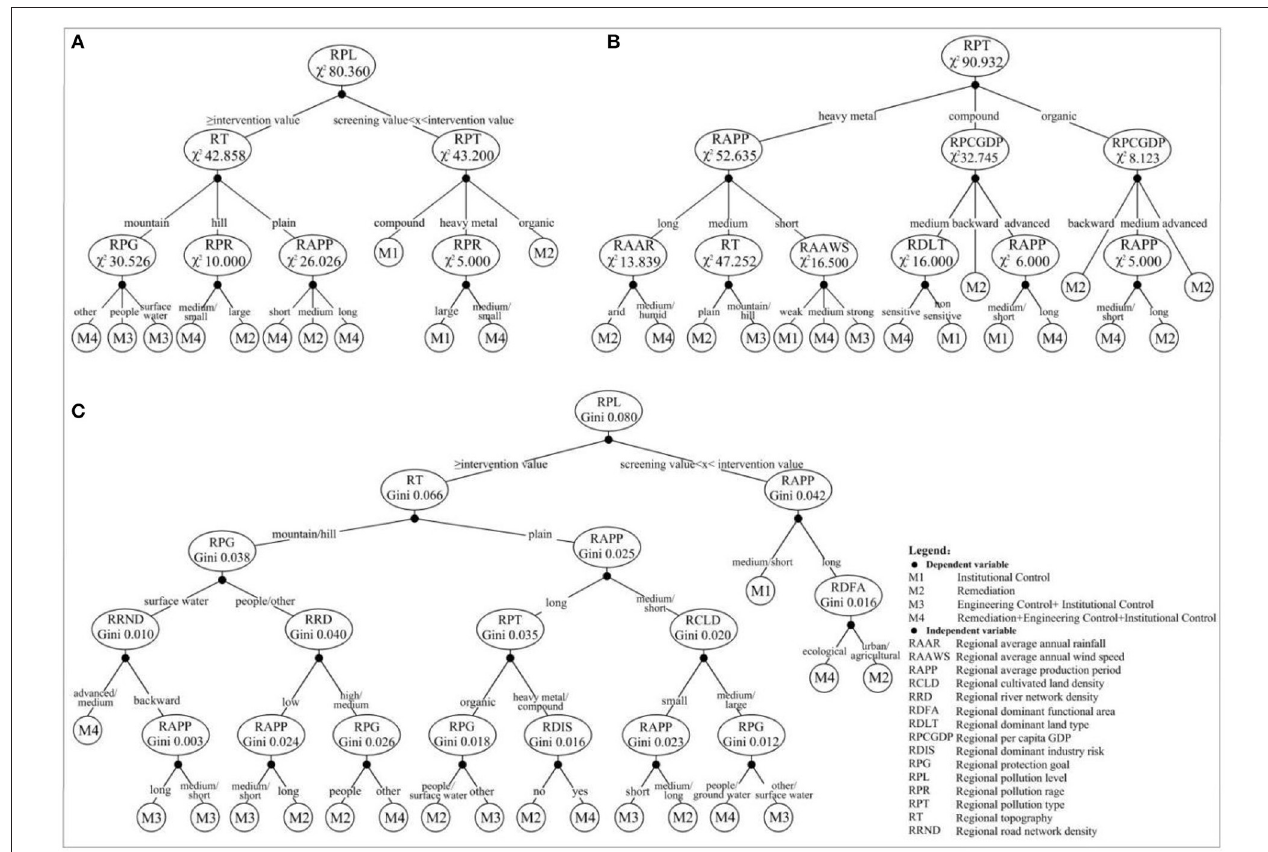
FIGURE 2 | The DT model based on CHAID algorithm (A) , E-CHAID algorithm (B) , and CART algorithm (C) .